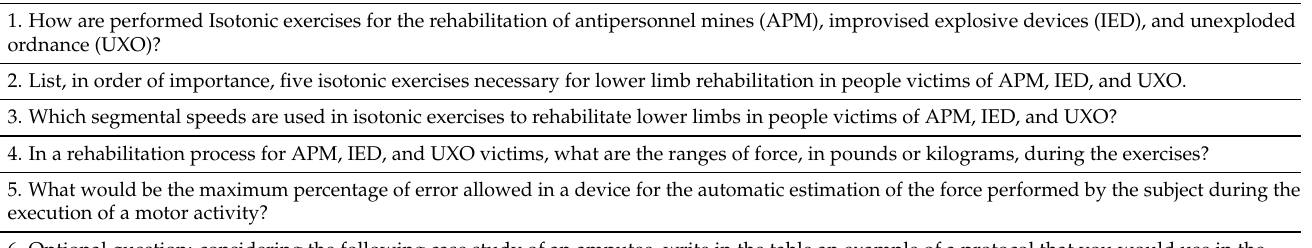
Table A1. Questions included in the